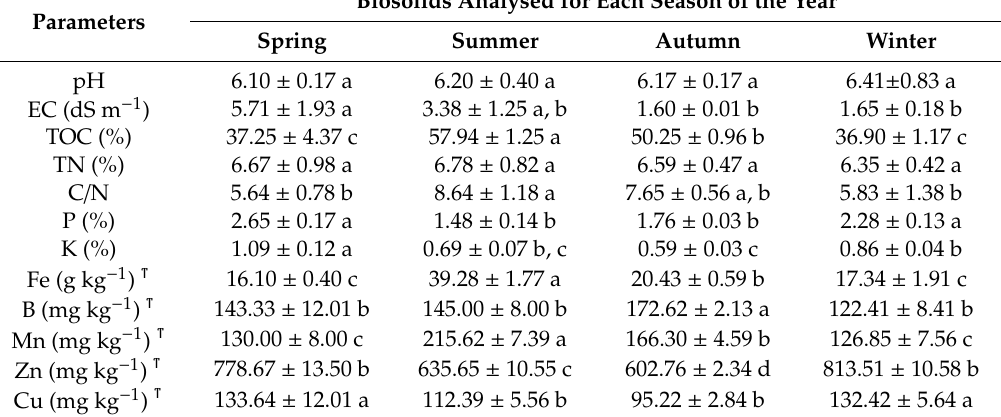
Table 2. Physicochemical characteristics and nutrient content in biosolids collected and evaluated in the urban wastewater treatment plant (UWWTP) at di ff erent season of